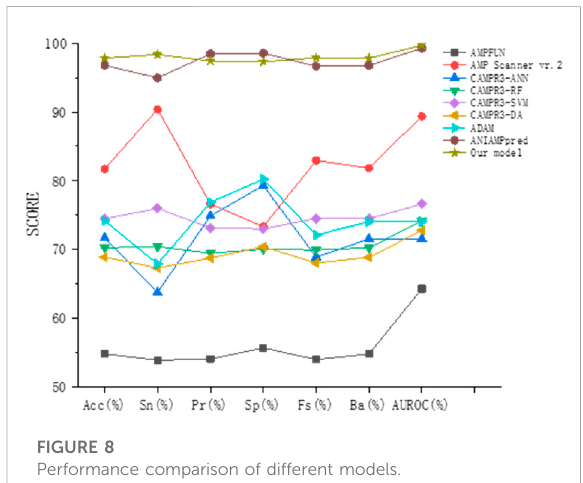
FIGURE 8 Performance comparison of different